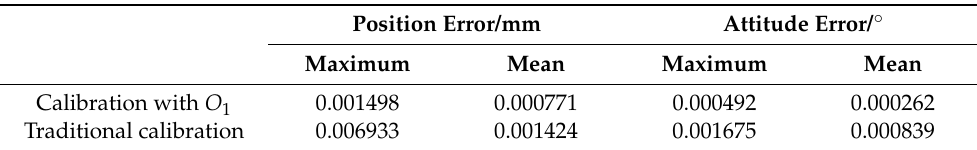
Table 8. Position error and attitude error after calibration using two methods.